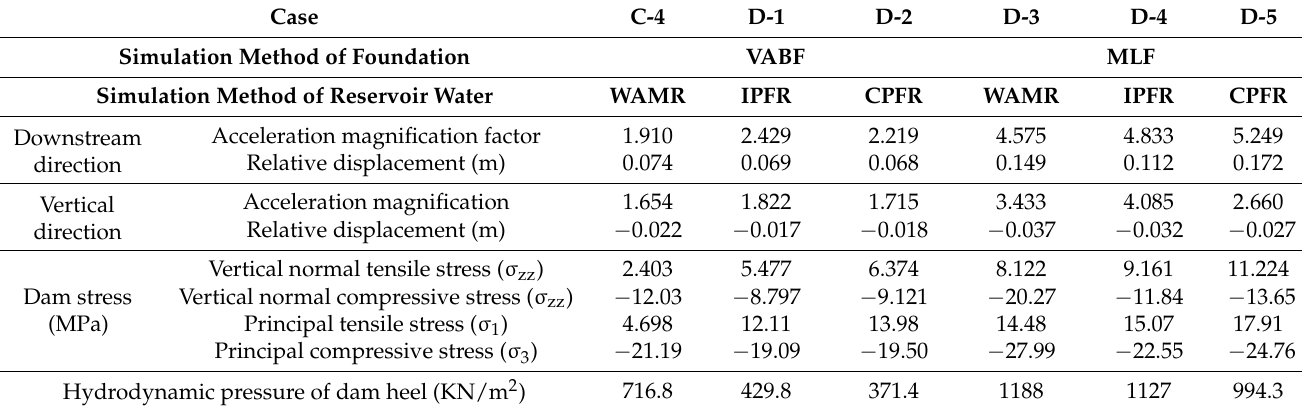
Table 8. The extreme values of dam dynamic responses for different reservoir simulation